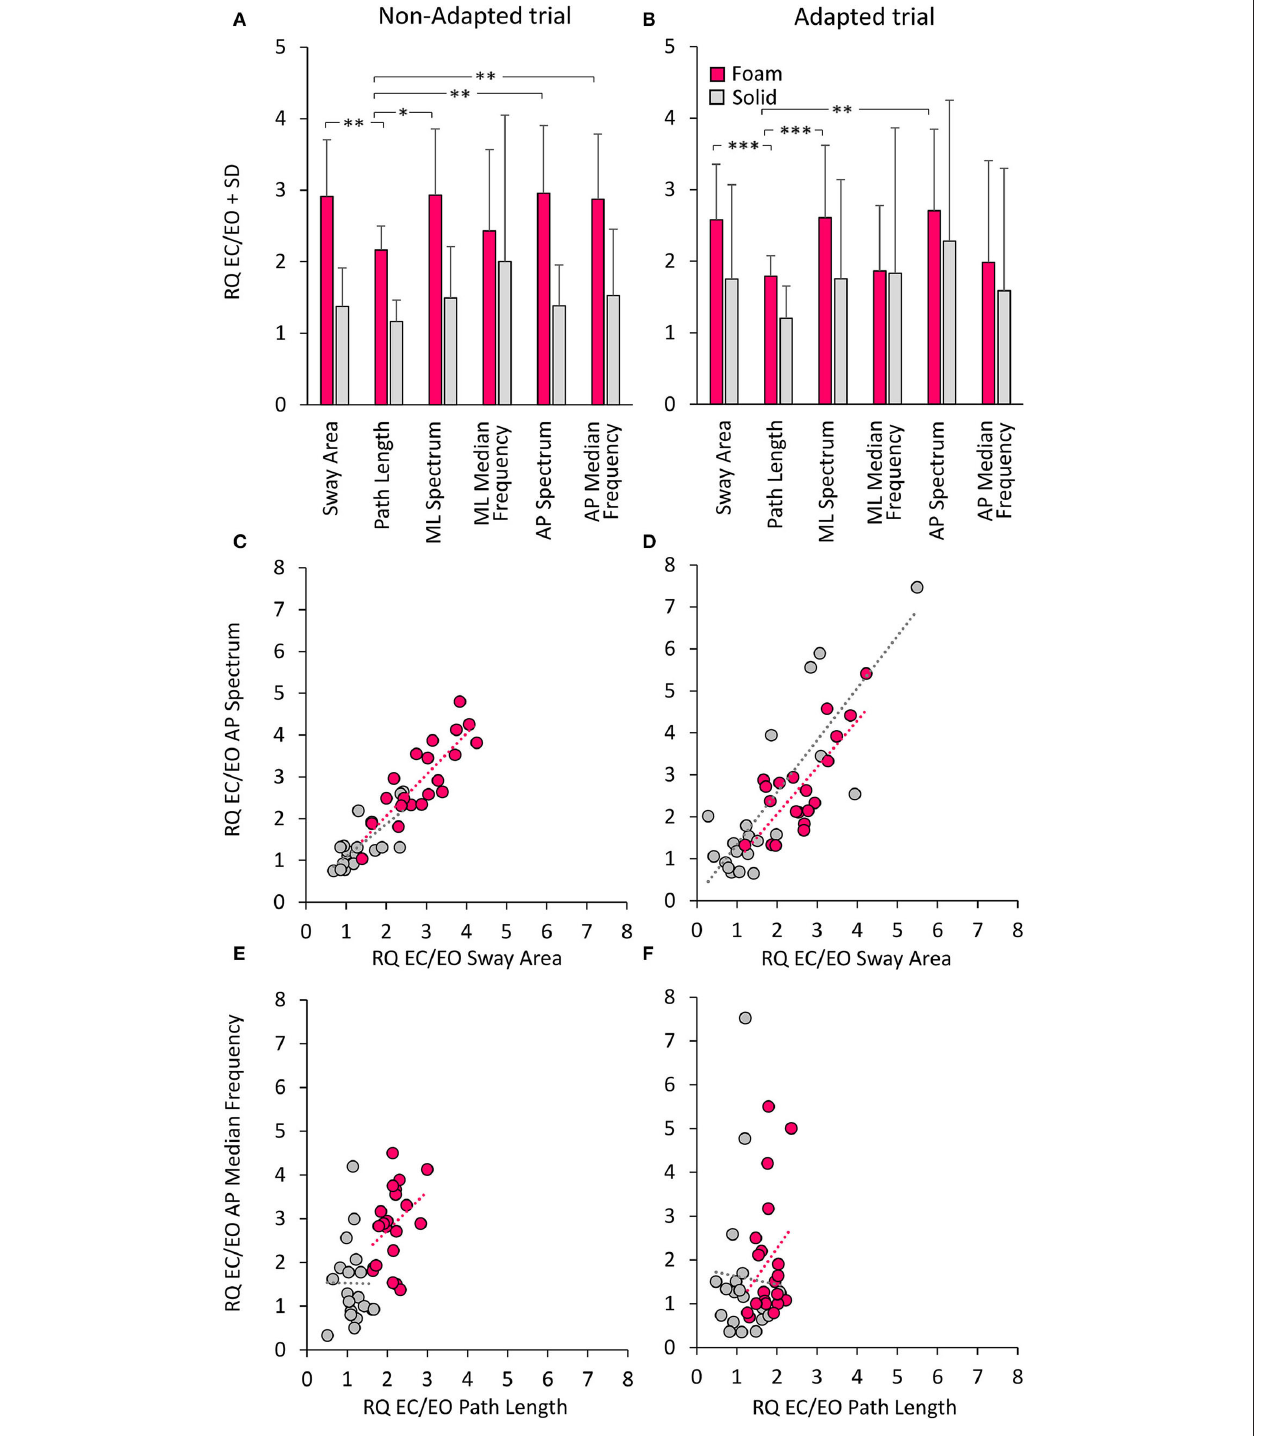
FIGURE 10 | Romberg Quotients (RQ) of geometrical and spectral variables. The top panels show the RQs for the non-adapted (A) and adapted (B) trials and for the Foam (pink) and Solid (grey) support conditions. Asterisks indicate significant differences (*, p < 0.05; **, p < 0.01; ***, p < 0.001). The middle panels show the relationship between RQs of AP Spectrum Level and RQs of Sway Area for both non-adapted (C) and adapted trials (D) (Foam, pink; Solid, grey). Each circle corresponds to a subject. The bottom panels show the relationship between RQs of AP Median Frequency and RQs of Path Length for both non-adapted (E) and adapted trials (F) . The apparent proportionality between the RQs calculated on Median Frequency and Path Length is related to the overall shift to the left of the Path Length dots in Solid support condition.